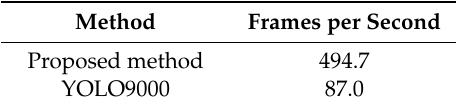
Table 5. Average processing speed for standing-pigs